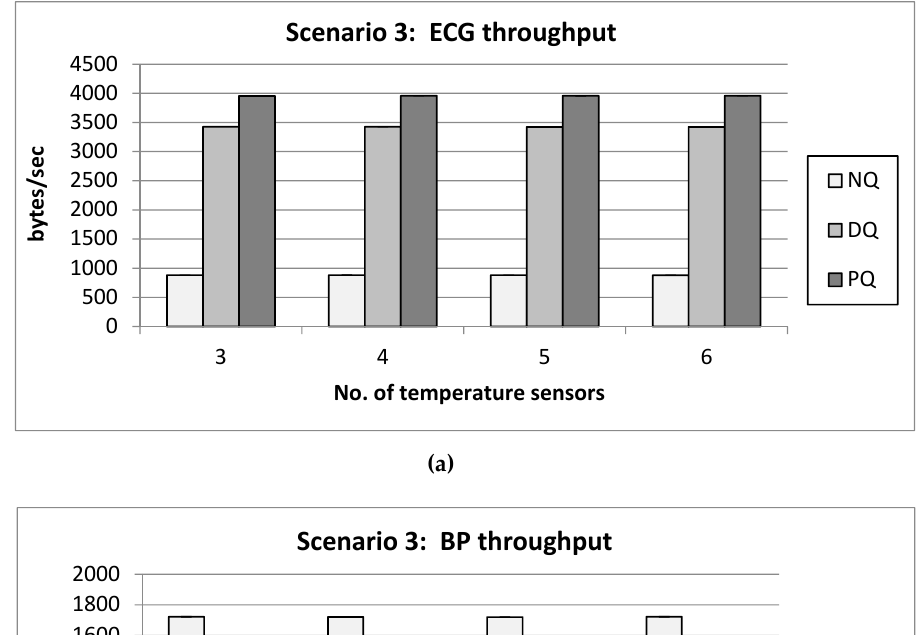
Figure 10. Average end-to-end packet delay results comparison for various data traffic types .